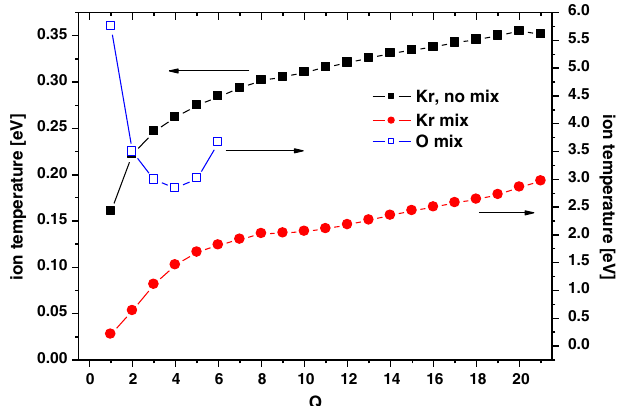
FIG. 10. Charge state dependence of the ion temperature for krypton ions in the pure krypton discharge (left scale, solid black squares) and in the mix of krypton and oxygen (right scale, red circles). Temperatures of oxygen ions are shown as open blue squares (right